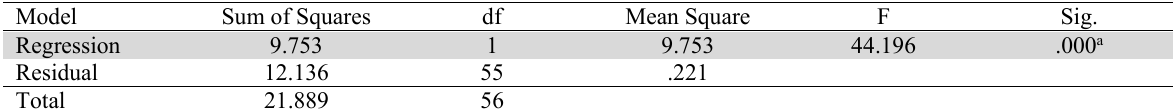
The results of the ANOVA test Model